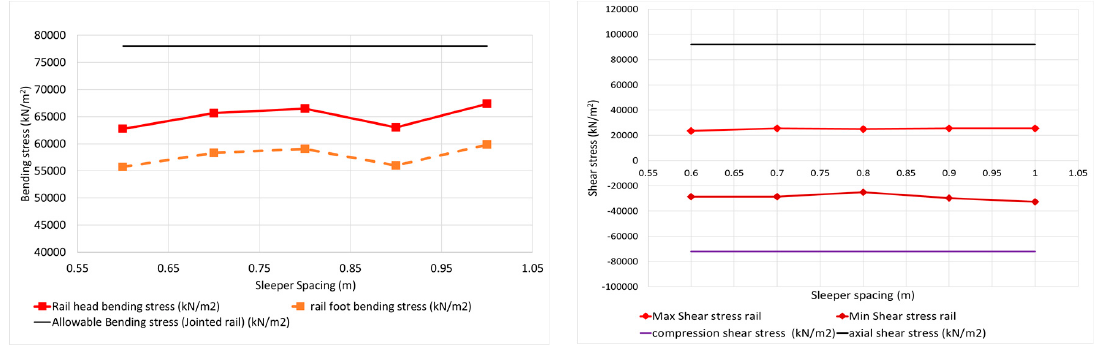
Figure 10. Maximum allowed limits for vertical displacements on rails and sleepers according to Table 7 values.